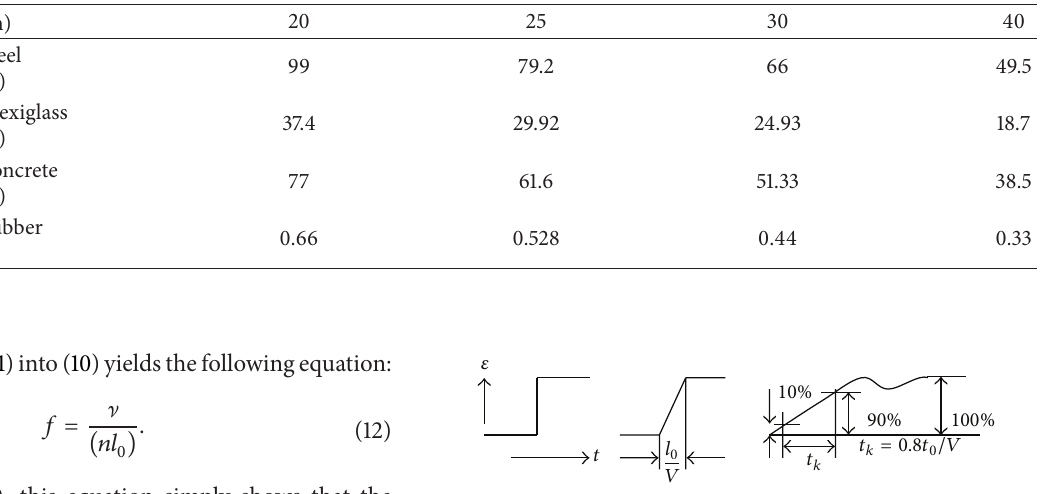
Table 2: The maximum working frequency of FBG strain sensor (strain wave is step wave).